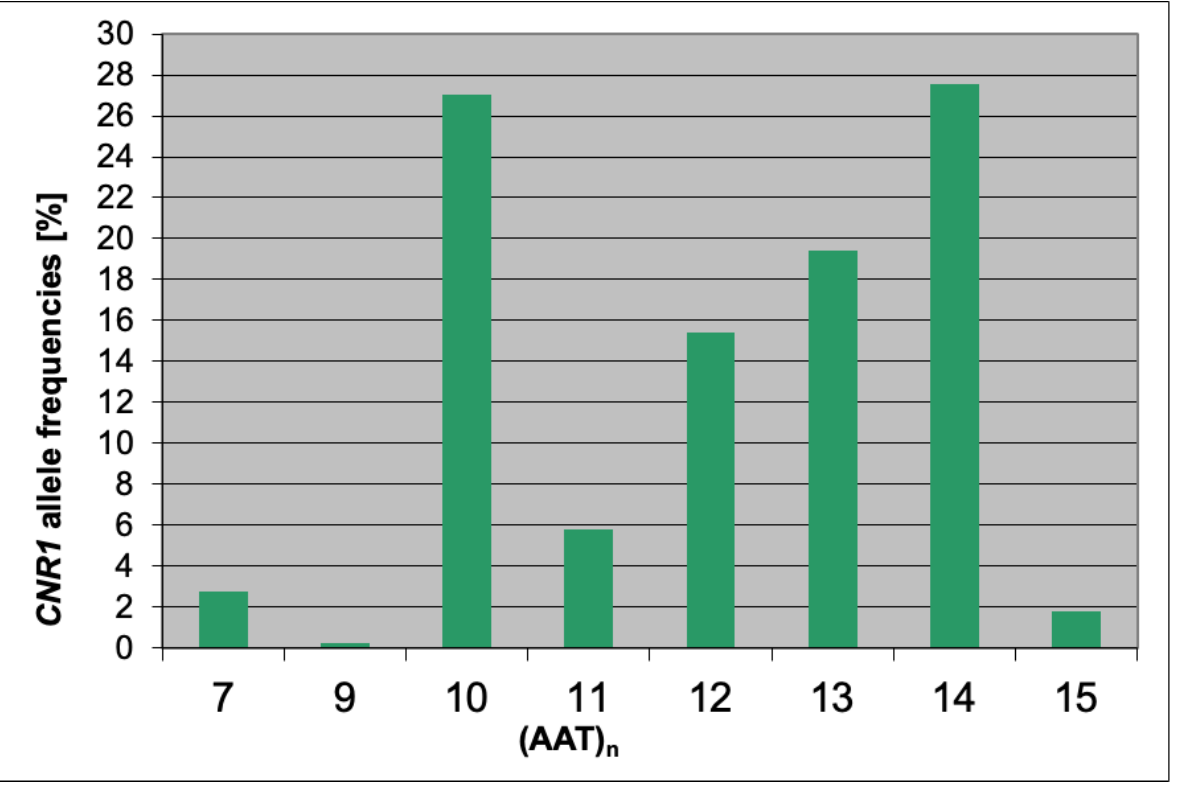
Figure 1. Frequency of CNR1 (AAT)n allele frequencies in patients after hip arthroplasty. At the same time, Table 4 shows the frequency of CNR1 genotypes (alleles classified as short or long, according to the determined number of AAT repeats).